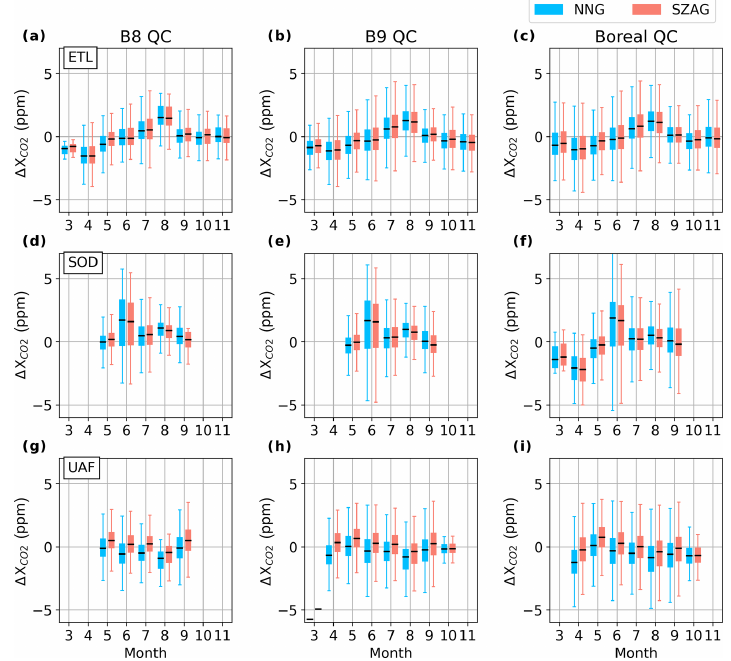
Figure C1. Monthly bias distributions for coincident OCO-2 retrievals filtered with boreal QC and referenced to NNG (black) alongside monthly bias distributions for coincident OCO-2 retrievals with boreal QC and referenced to SZAG